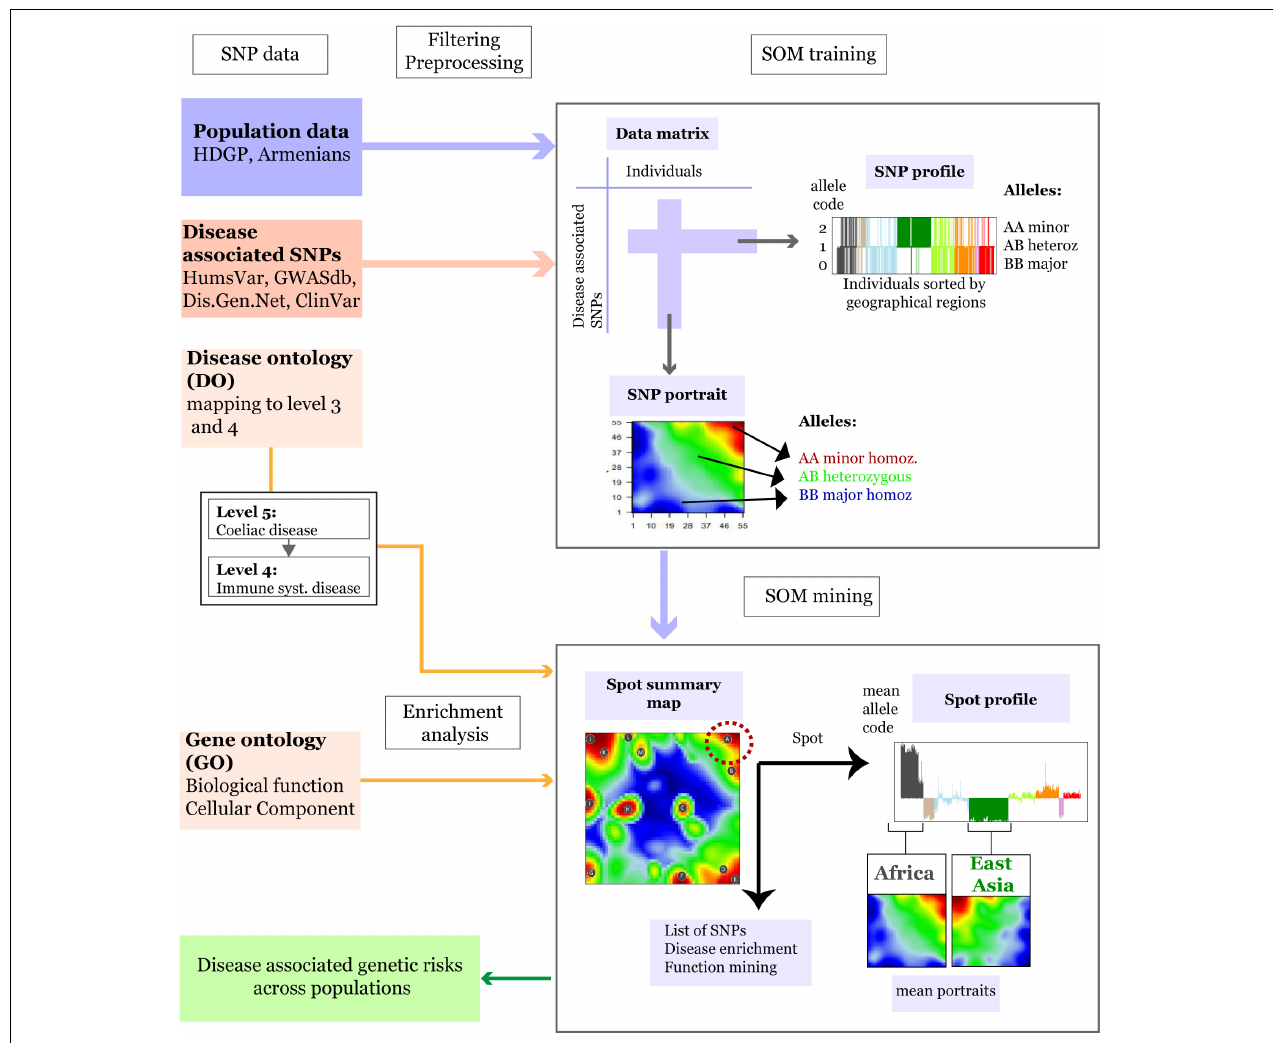
FIGURE 1 | Schematic overview of the SOM-portrayal method applied for analysis of population SNP data (see section “Materials and Methods”). SNP data of different populations around the world taken from the Human Genome Diversity Project (HDGP) and of a cohort of 99 Armenians were filtered for disease associated SNPs collected from four databases (see section “Materials and Methods”). Then, the data matrix (44,234 SNPs × 1039 individuals) was used to train a SOM which delivers a SNP portrait of each individual. It represents a colored image showing clusters of SNPs with increased minor allele frequency (MAF) as red ‘spot-like’ areas. They were then used for extracting population-specific associations with disease risks and biological functions by applying enrichment techniques. The SOM mining step also makes use of overview maps summarizing all spots observed on population averaged mean portraits which characterize the SNP landscape of individuals of a certain geographic region and of SNP profiles showing the allele score across all individuals and populations studied. For example, the red minor-allelic spot in the right-upper corner of the map (see dashed circle) is specific for Africans because it is observed in their portraits but not in the portrait of Europeans. Its profile shows high and low values of the allele score for individuals from these regions. Each of the spots delivers a list of SNPs and associated genes, which, in turn, are used to extract disease risks for populations showing these